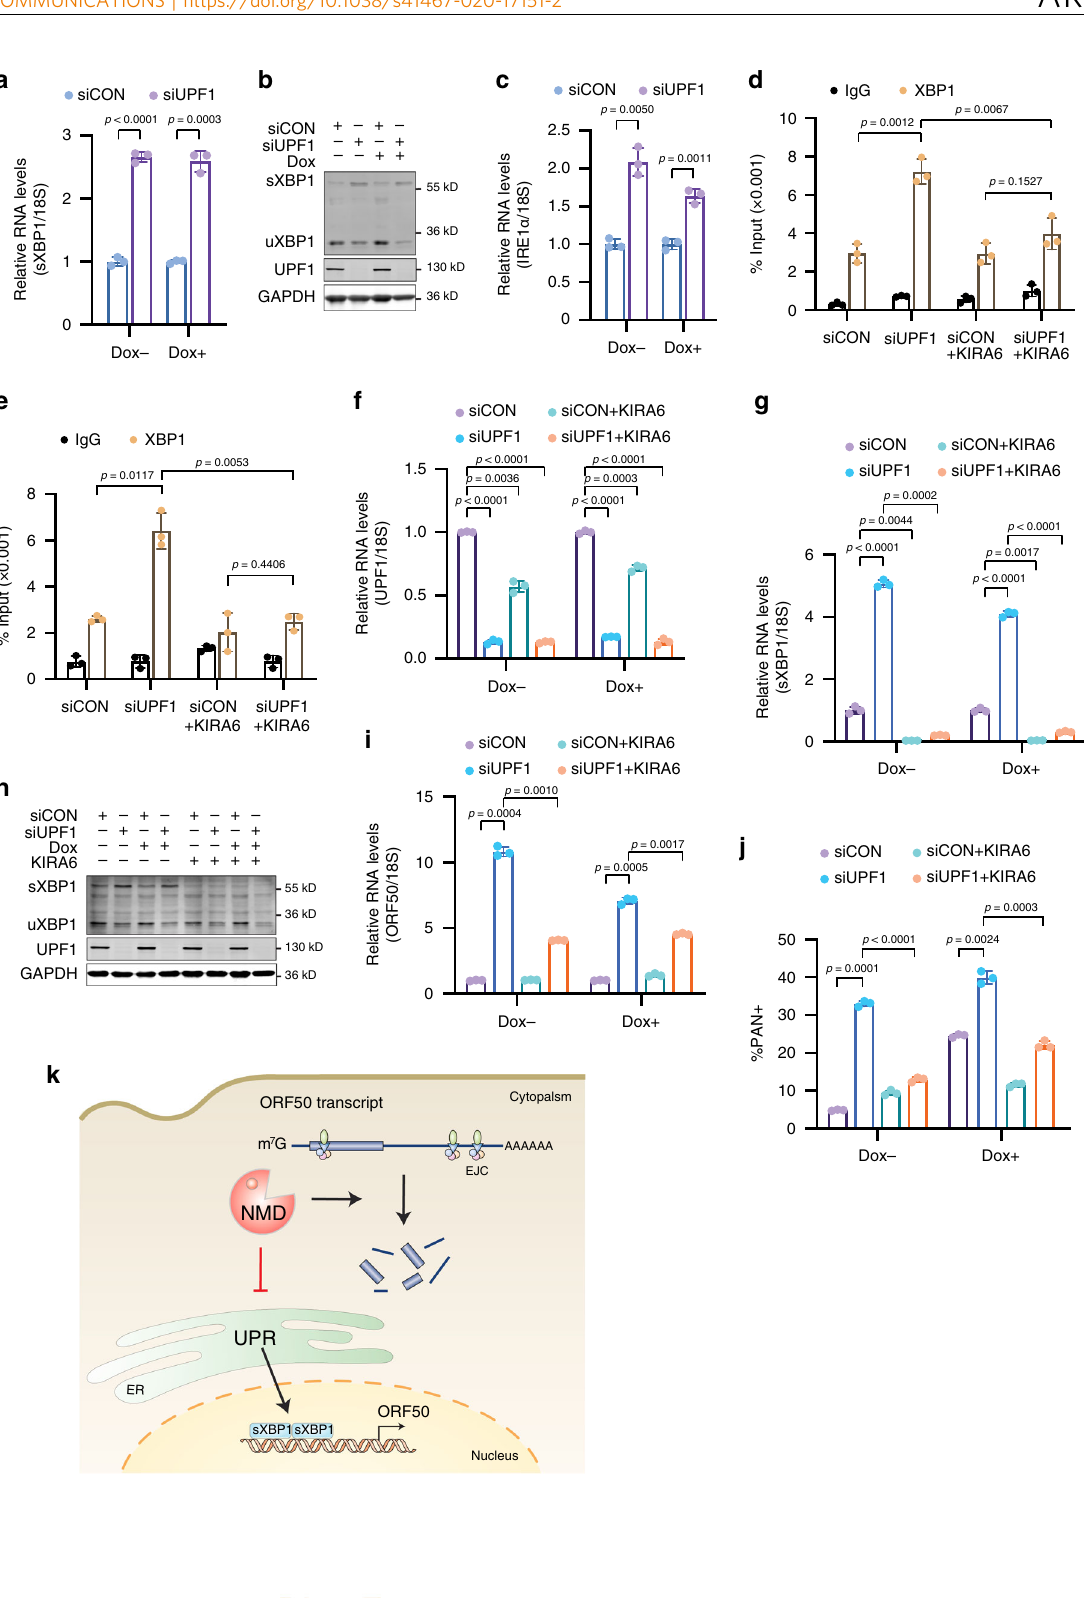
cell to regulate the RNAs expression, such as through the acti- vation of NMD when located within a 3 ′ UTR. Along this line, our experiments demonstrate that the ORF48 3 ′ UTR, which harbors the ORF46 intron, is suf fi cient to confer NMD sensitivity in a heterologous context. Moreover, >90% of the viral RNAs